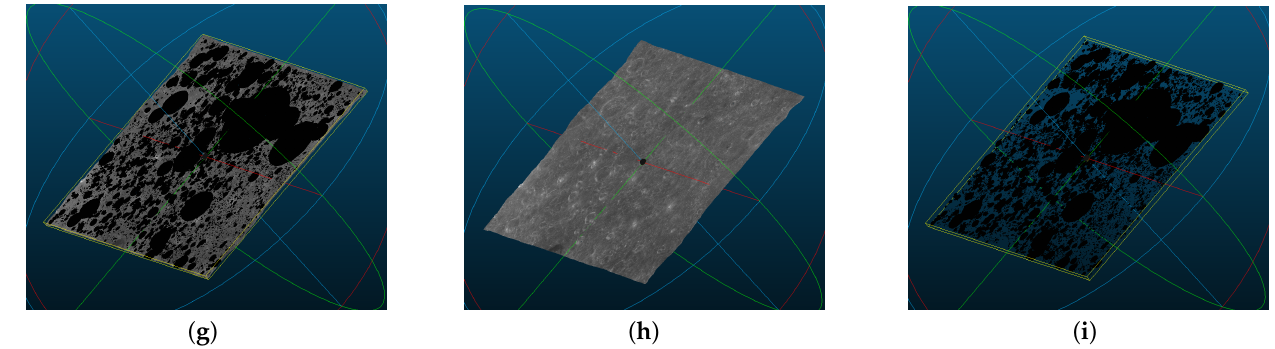
Figure 17. The three-dimensional structure of CE 2_ GRAS _ DEM _50 m _ K 003_49 S 120 W _ A , where ( a ) is all point clouds with crater semantic information, ( b ) is all point clouds without semantic information and ( c ) is only crater point clouds. ( d – i ) are the display of ( a – c ) from different perspectives.